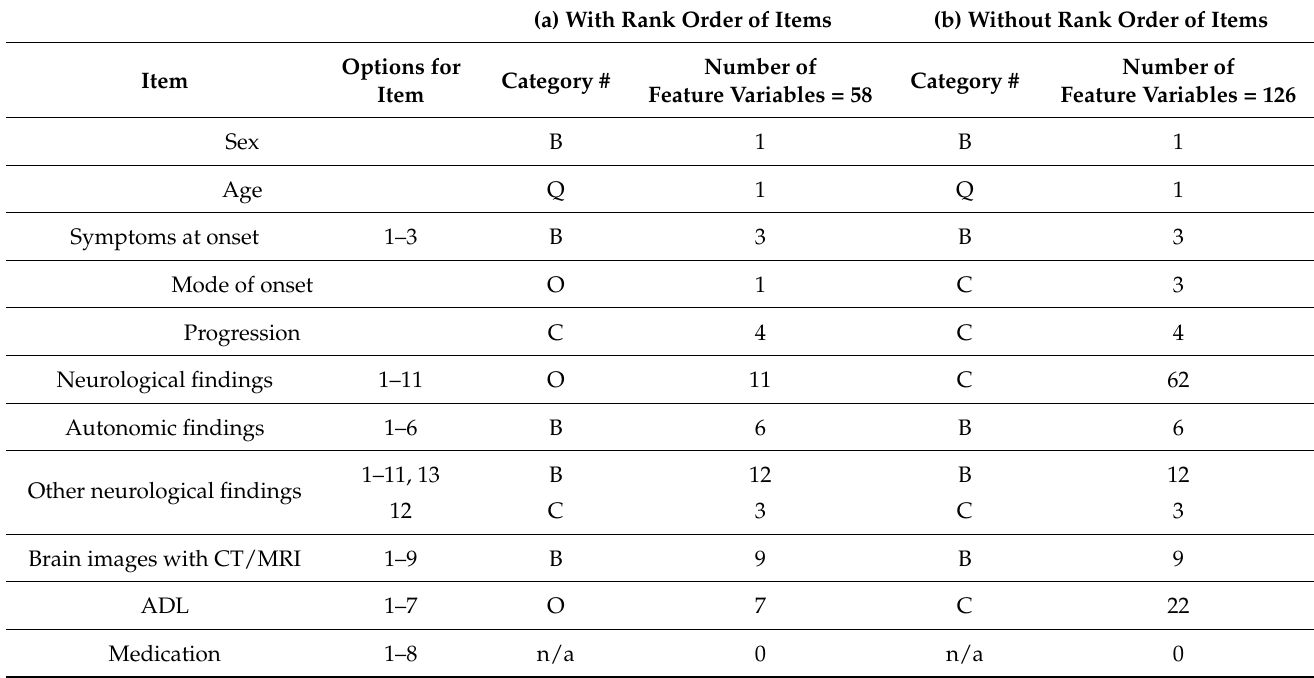
Table 3. Datasets used in the pointwise linear model. (a) With Rank Order of Items (b) Without Rank Order of